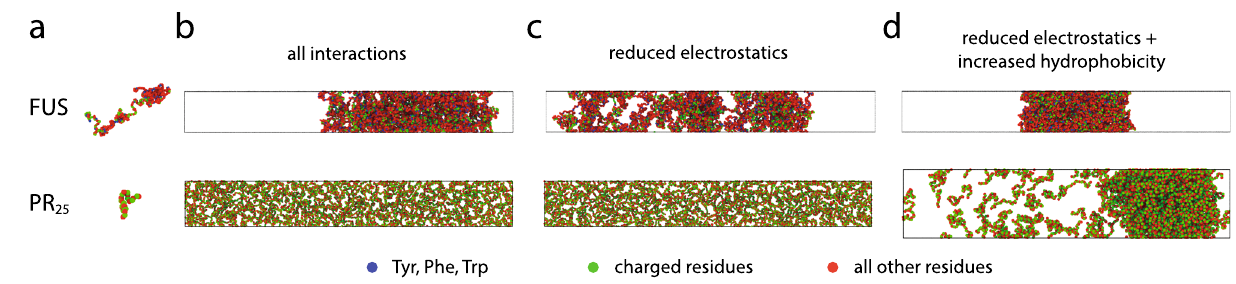
Fig. 7 Dependence of LLPS on electrostatic versus hydrophobic forces for FUS and PR 25 from direct coexistence simulations using a sequence- dependent protein coarse-grained model. a Illustration of the coarse-grained models for the different proteins with one bead representing each amino acid. Amino acids are colored according to their chemical identity (aromatics in blue, charged residues in green, all other residues in red; color code shown at the bottom). Snapshots for simulations with b all interactions, c reduced electrostatics, and d reduced electrostatics + increased hydrophobicity for FUS (24 proteins) and PR 25 (400 peptides). Snapshots were rendered using Ovito 124